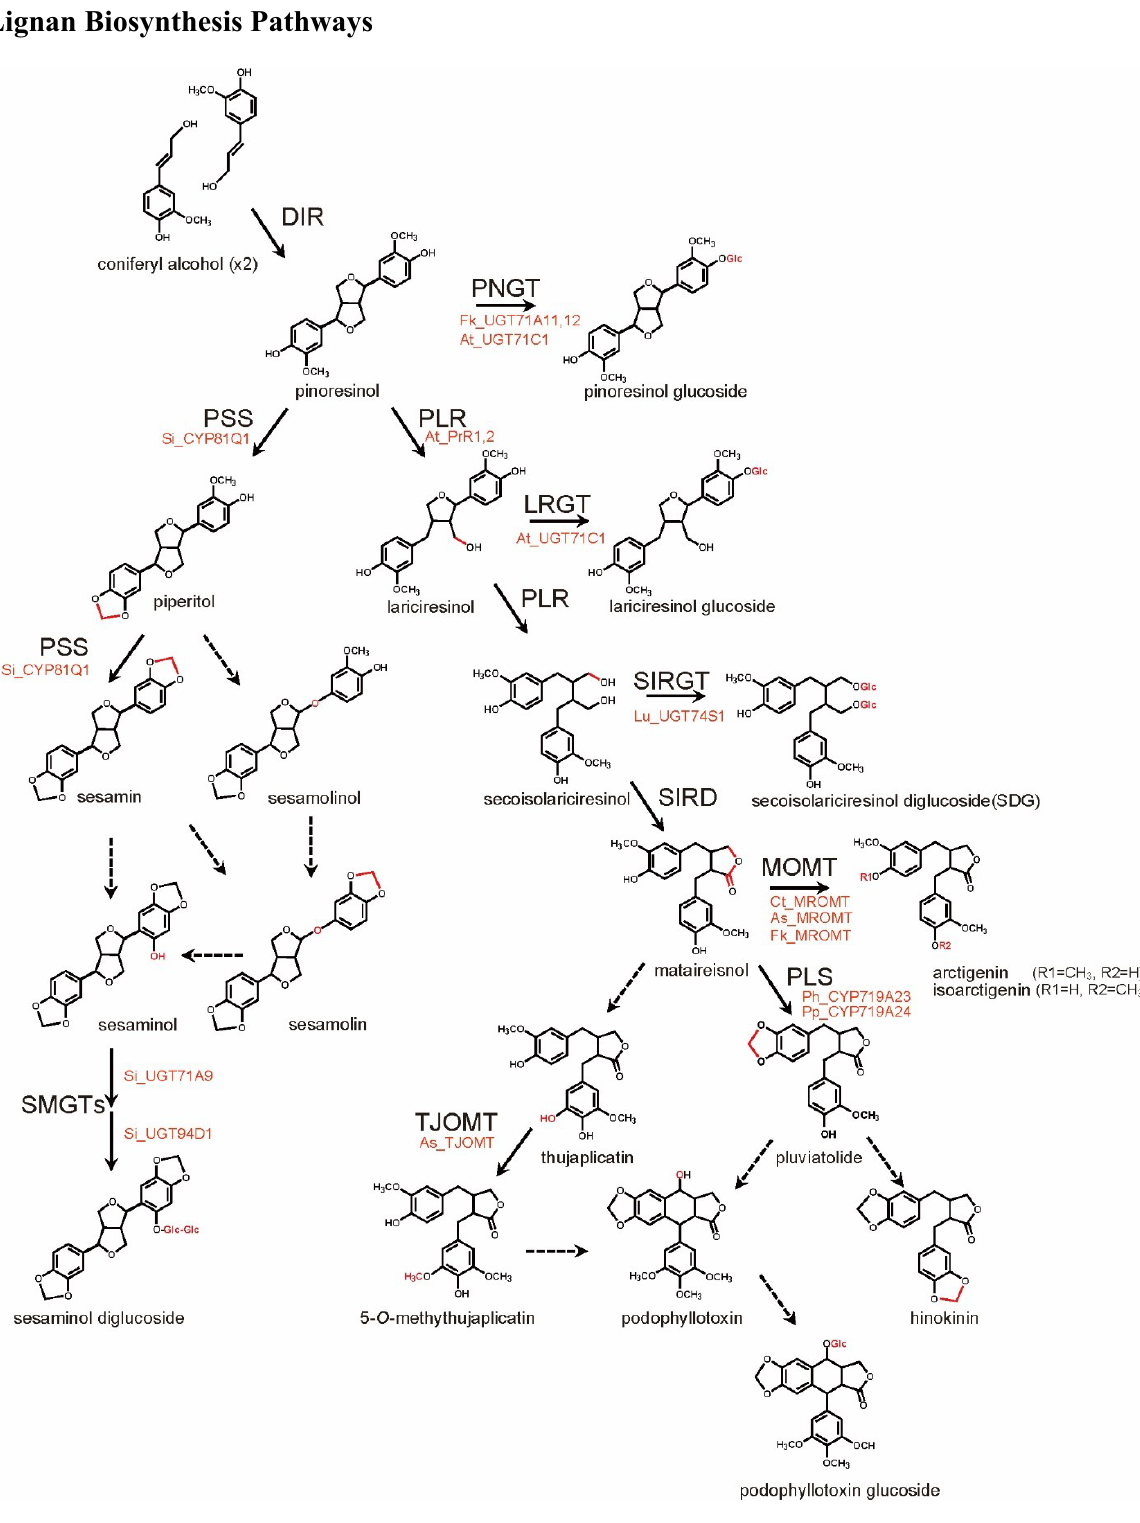
Figure 2. Biosynthesis Pathways of Major Lignans. Chemical Conversions at Each Step are Indicated in Red. Solid and Broken Lines Represent Identified and Unidentified Enzyme-catalyzed Reactions,